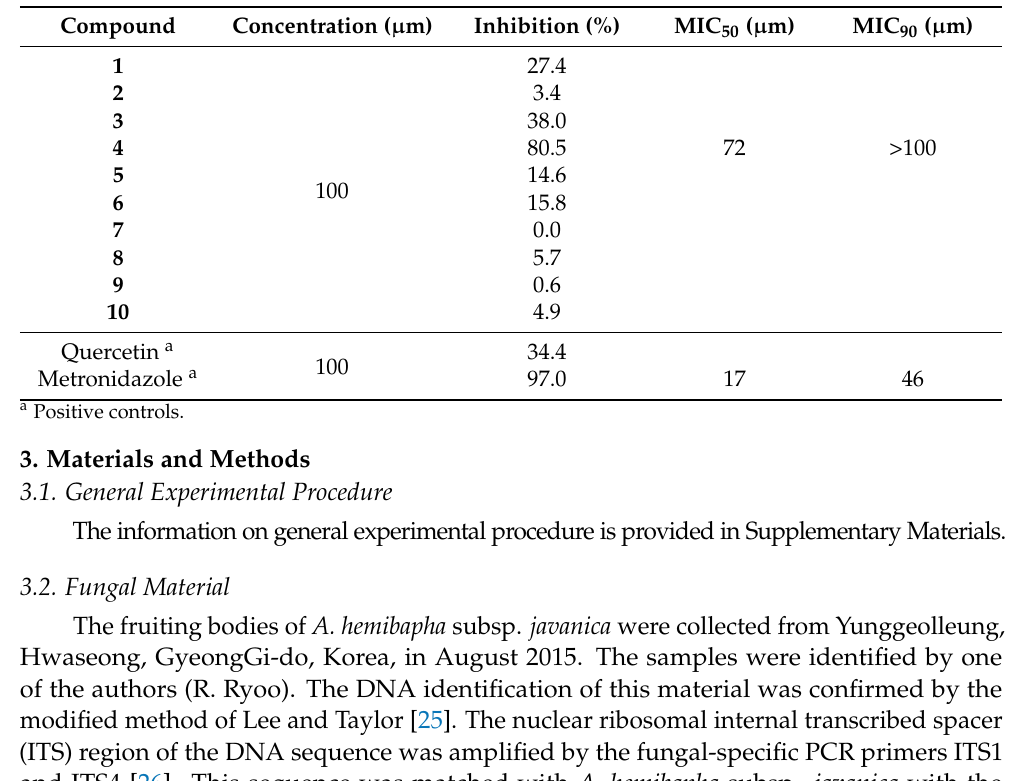
Table 1. Anti- H. pylori activity of compounds 1 – 10